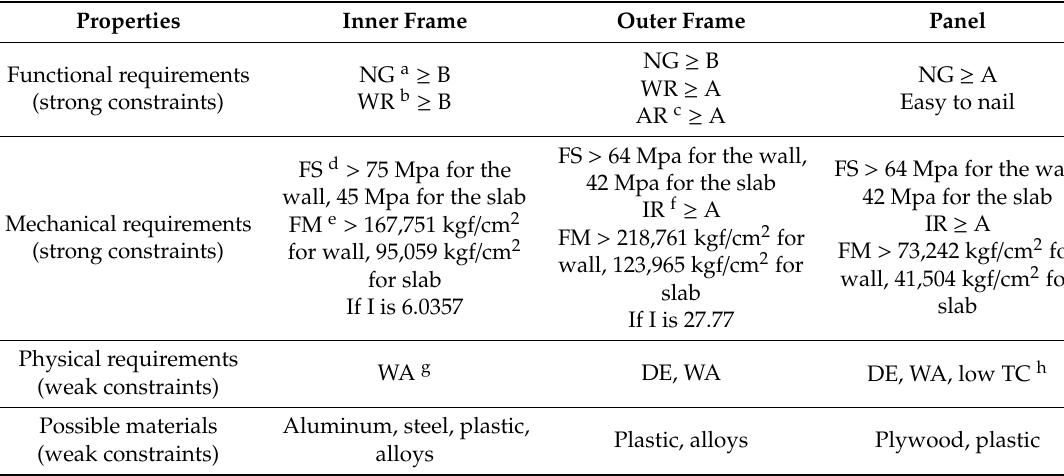
Table 5. Possible materials for each form